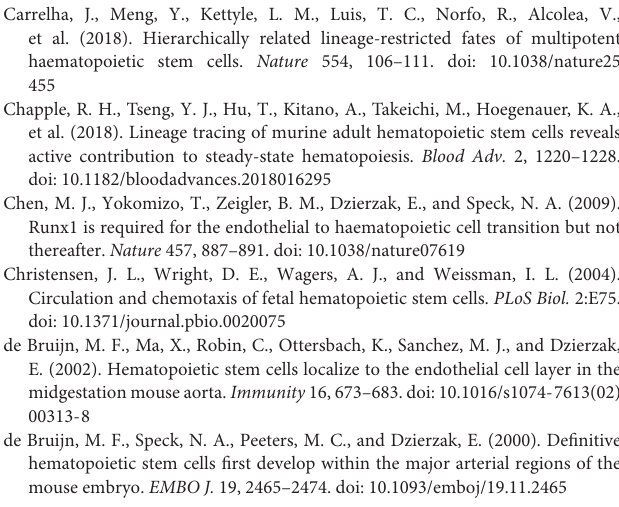
Supplementary Figure 1 | Gating strategies for FACS analyses of Hlf-tdTomato expression in different hematopoietic populations from Hlf-tdTomato mice. (A) Representative FACS plots showing the expression of Hlf-tdTomato in Gr1 + cells and F4/80 + macrophages in E15.5 fetal liver (FL). Data are representative of two independent experiments. (B) Representative FACS plots showing Hlf-tdTomato expression in the indicated hematopoietic populations in the adult bone marrow (BM). LT-HSC, long-term hematopoietic stem cell; ST-HSC, short-term hematopoietic stem cell; MPP, multipotent progenitor; CMP, common myeloid progenitor; GMP, granulocyte-monocyte progenitor; MEP, megakaryocyte-erythroid progenitor. Data are representative of three independent experiments. (C) Representative FACS plots (left) and graph (right) showing the Hlf-tdTomato expression in LT-HSCs, ST-HSCs and MPPs in the bone marrow representative of two independent experiments.